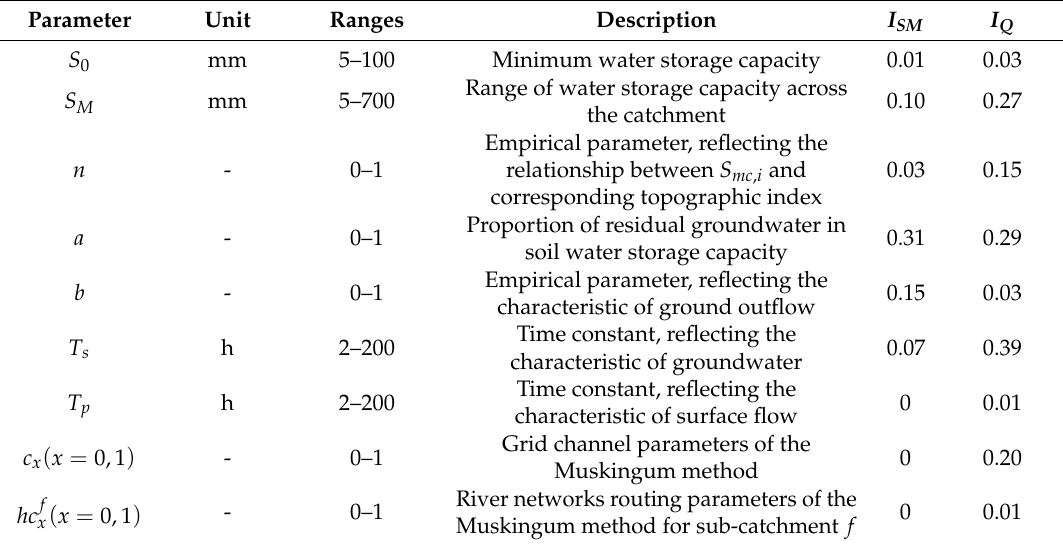
Table 1. Details of DDRM parameters. Sensitivity indexes I SM and I Q represent sensitivity to soil moisture and streamflow, respectively. Higher values mean high